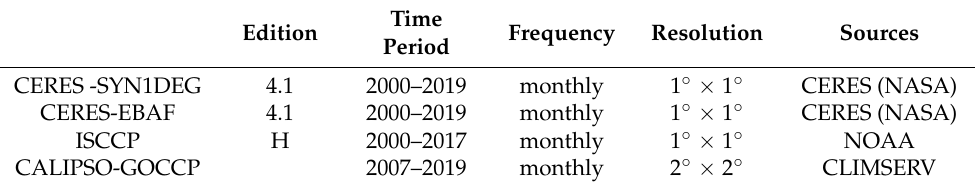
Table 1. The satellite cloud products used in